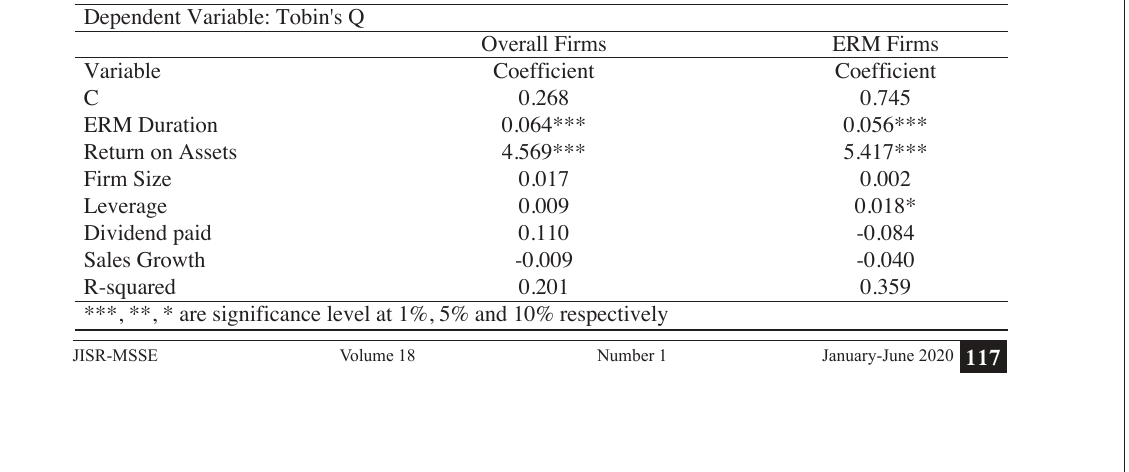
Results of Relationship between ERM Duration and Firm's